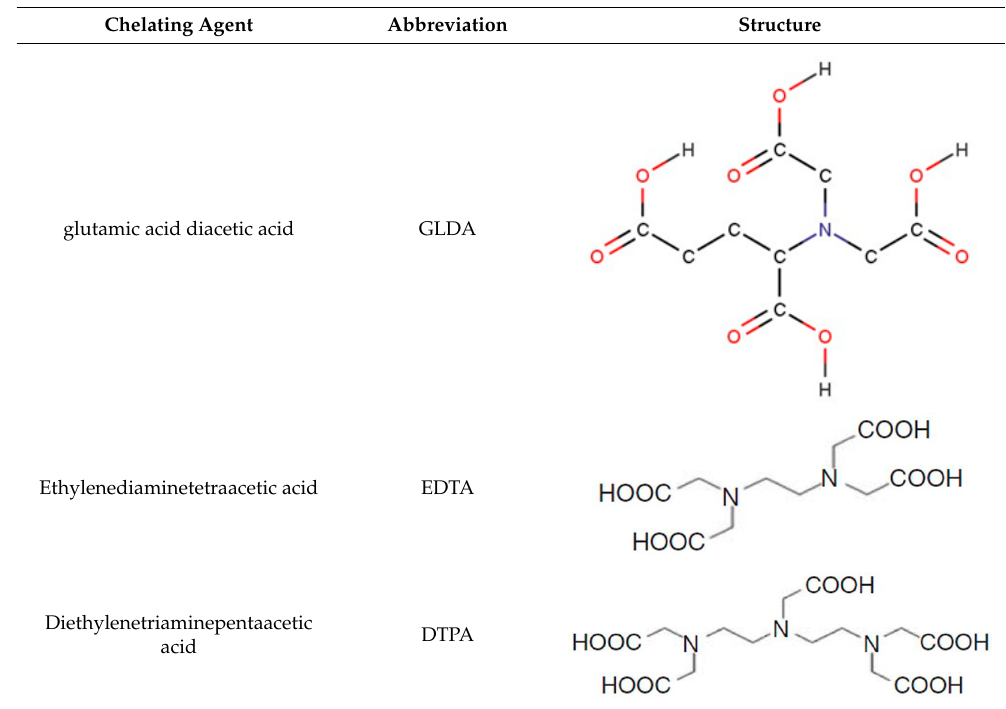
Table 2. The structure of the chelating agents used in this study.